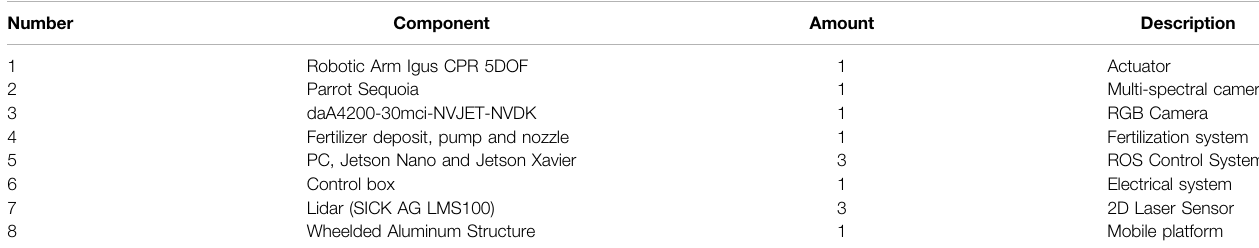
TABLE 1 | Mobile platform components.